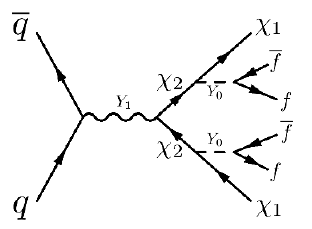
Figure 3 . A representative diagram from the DisplacedDM model that produces displaced verticies plus =E T . The subscripts on Y indicate the spin of the